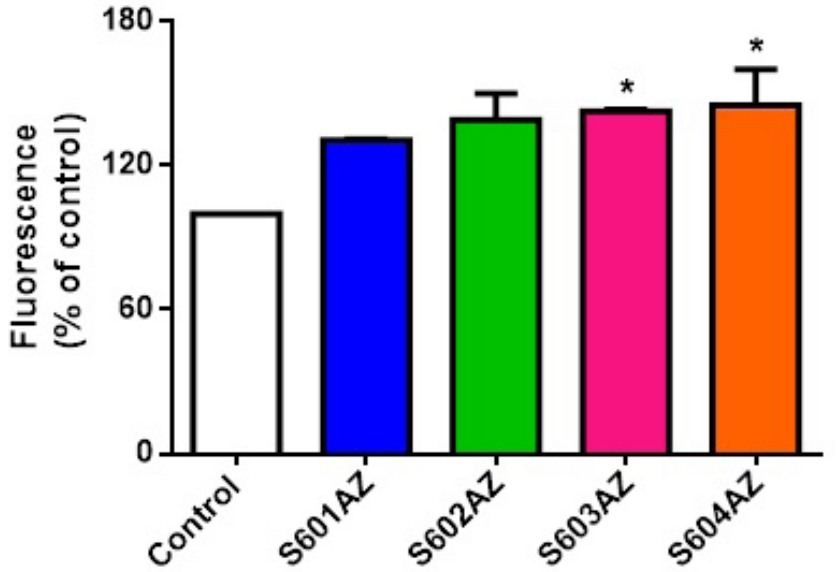
Figure 5. Fluorescence quantification of CF1553 animals treated with β-aryl-chalcogenium azide compounds at concentration of 10µM. Data represent the mean ± SEM of three to four experiments. * p<0.05 as compared to